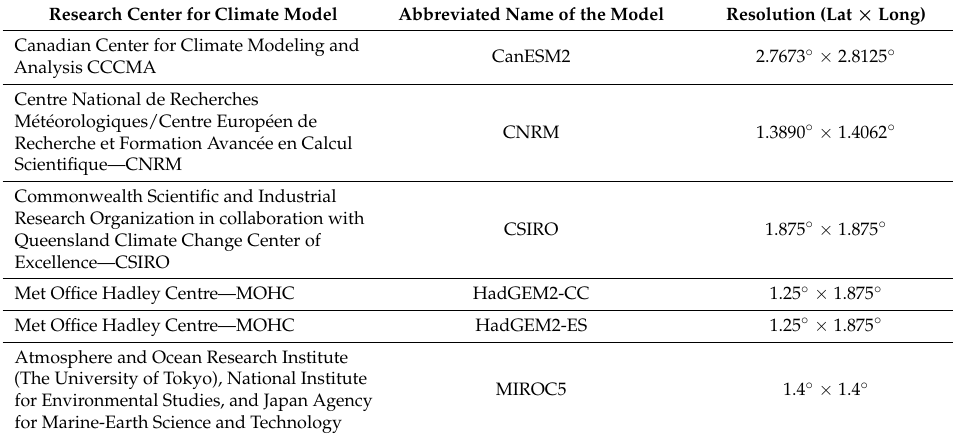
Table 3. Resolutions and abbreviations of the six models